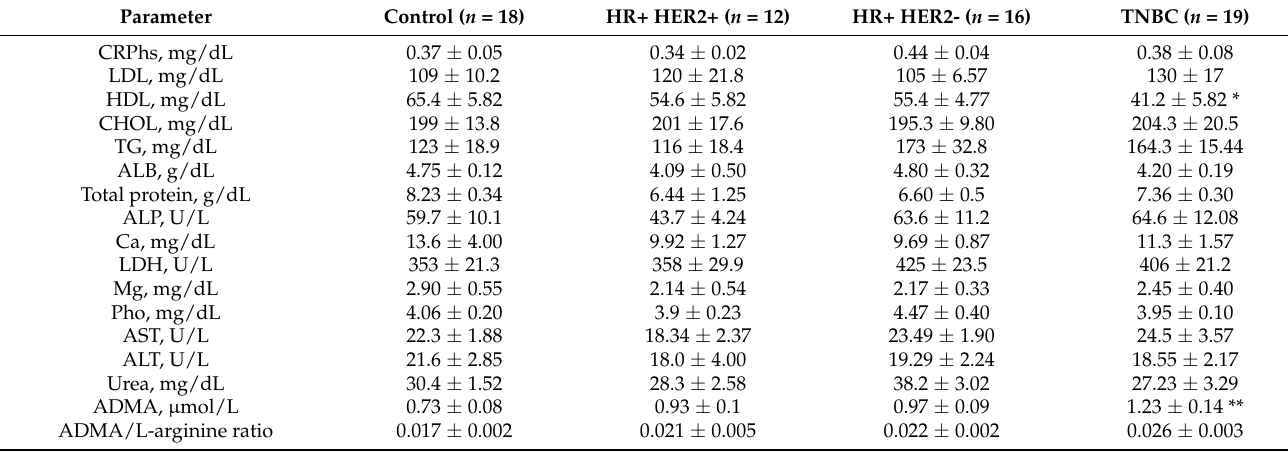
endothelial function parameters (Table 1). TNBC patients had significantly higher con- centrations of asymmetric dimethylarginine (ADMA), one of the endogenous inhibitors of nitric oxide synthase (NOS), compared to the control (Table 1). Breast cancer patients were also characterized based on the cancer histological type, involved lymph nodes, proliferation marker Ki-67, blood morphology, electrolytes concentration, and coagulation parameters (Tables 2 and S1–S3). There was a significantly higher % of Ki-67 among TNBC patients compared to the HR+HER2- group. On the other hand, the HR+HER2- patients had a lower Ki-67 compared to the HR+ HER2+ group (Table 2). When we analyzed patients with different subtypes of breast cancer, according to its stage, significantly higher lymph nodes involvement was noted at stage III as compared to previous stages in each of the studied groups (Tables S1–S3). Table 1. Clinical biochemistry profile and endothelial function parameters in controls and breast cancer patients.